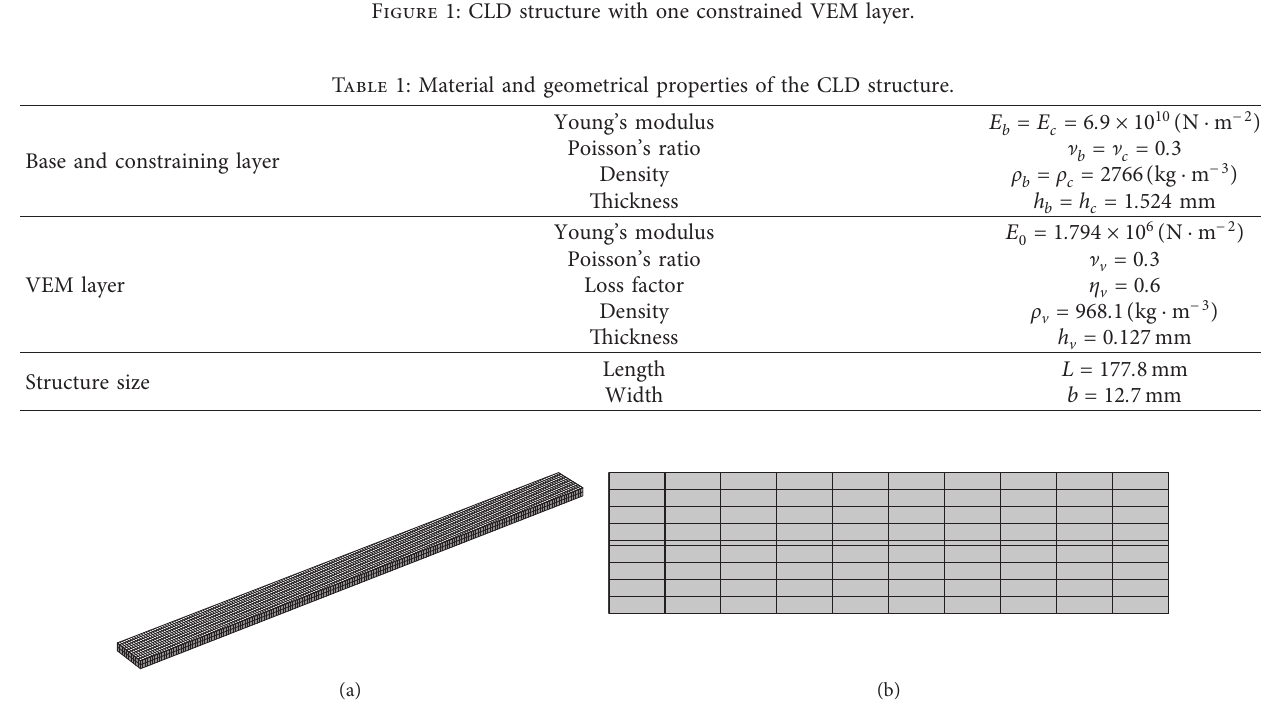
Figure 2: The meshed image of the CLD structure model in COMSOL. (a) The meshed image. (b) The cross-sectional view. Table 2: The comparison of the natural frequencies and associated loss factors of the first six modes.